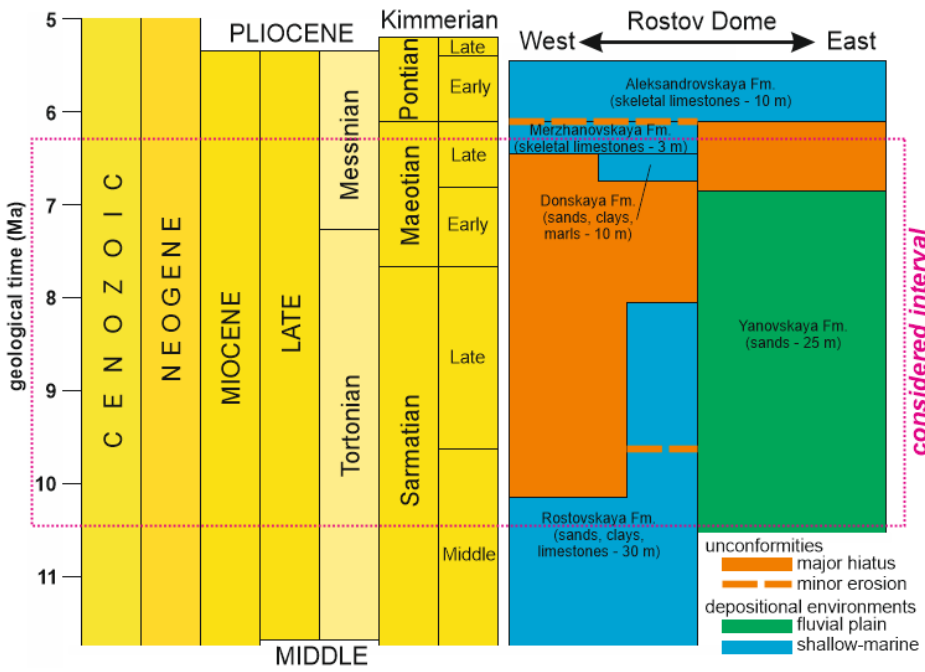
Figure 2. Stratigraphical framework of the Sarmatian–Maeotian transition; eteropic lateral relationships of units are shown (created by the author; some previous sources were referred for information: geological time scale after [28], regional units after [6,13], color codes follow [29], lithostratigraphy modified from [21,22]).